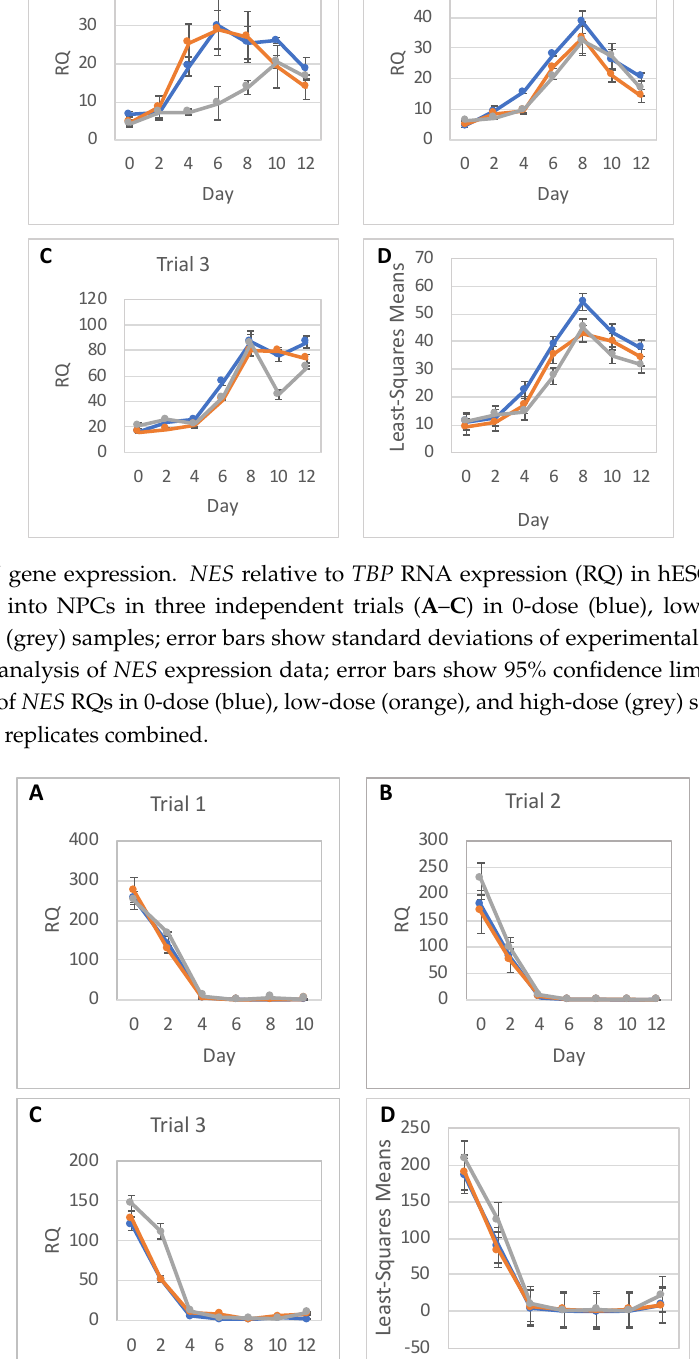
Table 4. Difference between 0-dose and high-dose groups in least square means of NES RNA expression according to day.